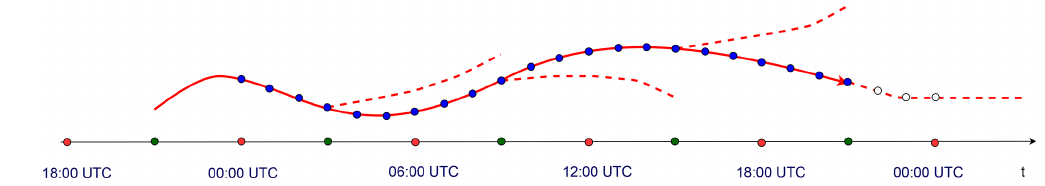
Figure 1. Graphical representation of 4D-EnVar analysis cycle during 24h using IAU initialization. The 4D-EnVar analyses are computed using a 6h assimilation window centered at 00:00, 06:00, 12:00 and 18:00UTC (red dots on the timescale). The GEM model (in coupled or uncoupled mode) 6h integration using an IAU initialization of the analysis increments (solid lines) starts at 21:00, 03:00, 09:00 and 15:00UTC (green dots on the timescale), followed by 6h computation of the background states for the next analysis (dotted lines). The 21 blue dots show the atmospheric states, available hourly, used as atmospheric forcing at 1h frequency for the NEMO–CICE model to compute coupled 24h ocean background within WCDA (see text). The last three forcing states of every 24h cycle are taken from the computation of the background fields (white